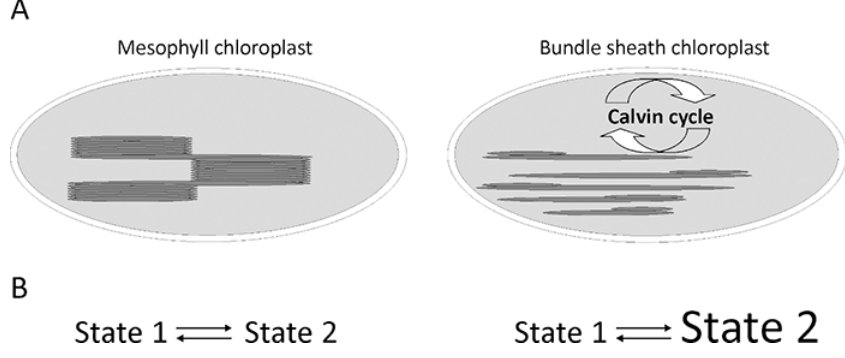
Figure 2 ( A ) Schematic of maize (NADP-malic enzyme C4 type) mesophyll and bundle sheath chloroplasts. ( B ) Model of State 1 to State 2 transitions in maize chloroplasts, where mesophyll chloroplasts have typical State 1 to State 2 transition; whereas bundle sheath chloroplasts have permanent State 2, where light-harvesting complex II antennas are bound to photosystem I (Rogowski et al.,